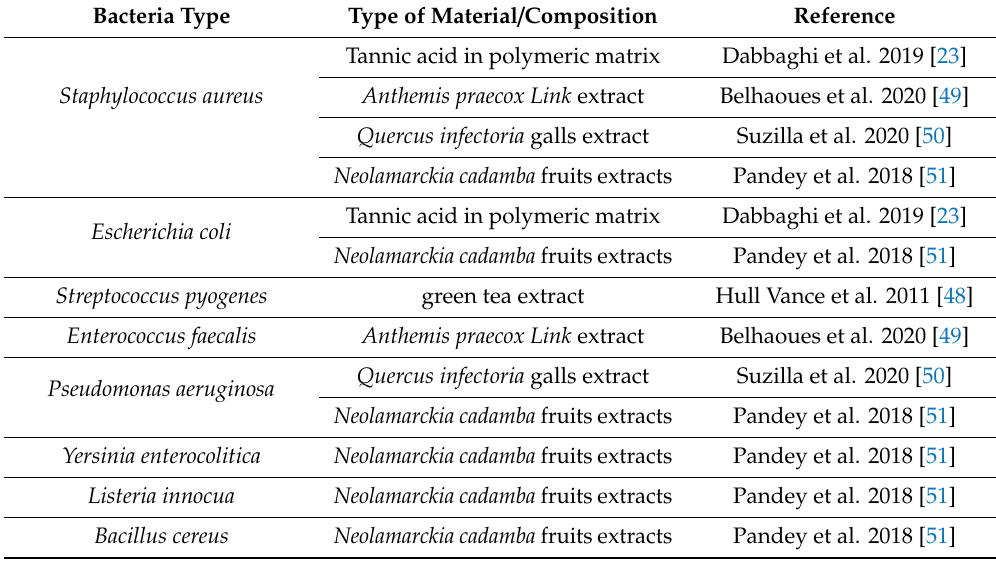
Table 2. Summary of tannic acid antibacterial